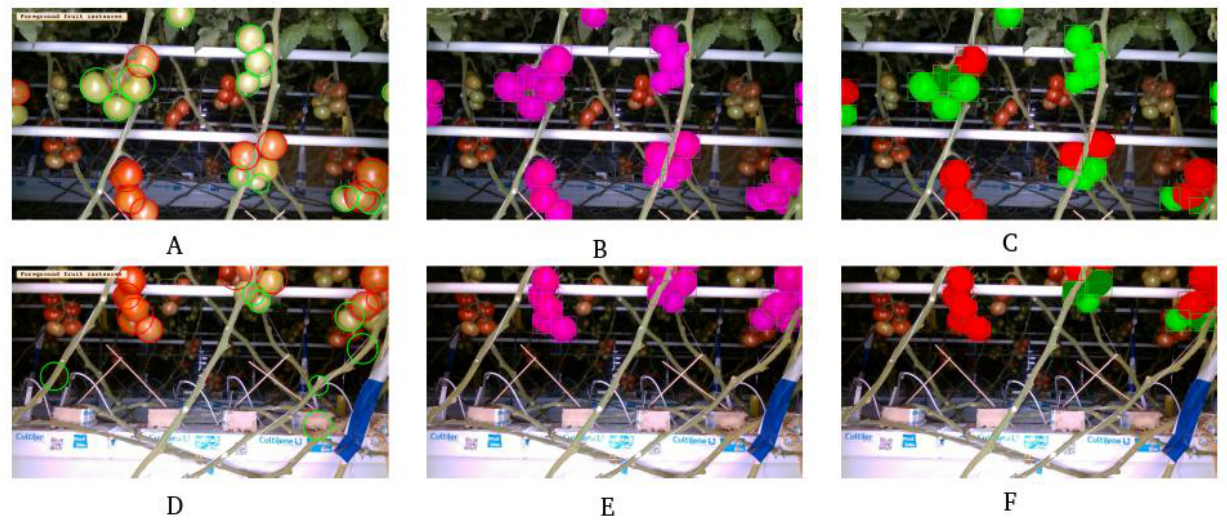
Figure 5. Example of detection of fruits using: ( A , D ) classical shape and colorspace segmentation, ( B , E ) MaskRCNN with one fruit class, ( C , F ) MaskRCNN with two ripeness